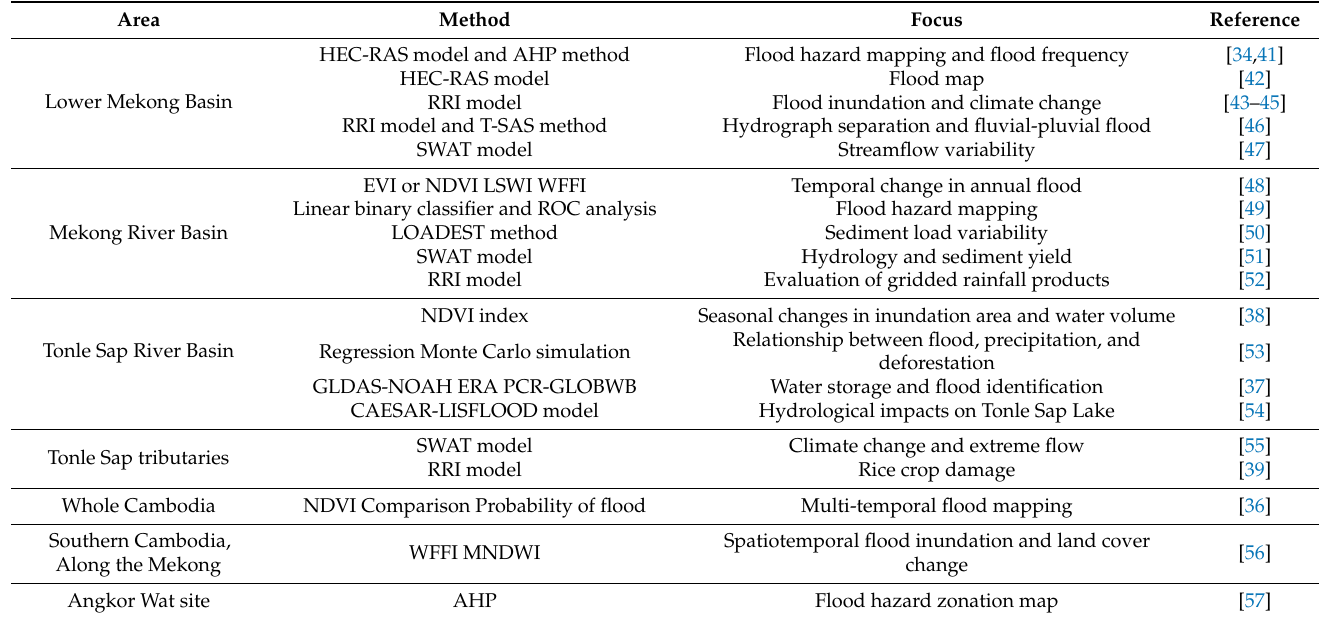
Table 1. Flood studies in Cambodia and its river